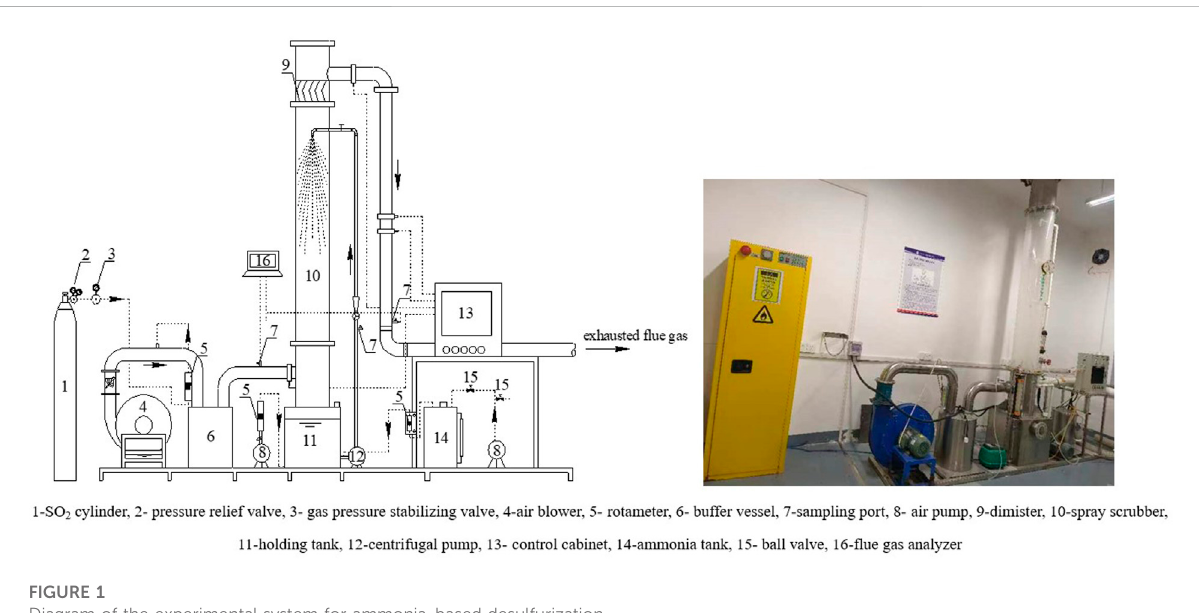
FIGURE 1 Diagram of the experimental system for ammonia-based desulfurization.